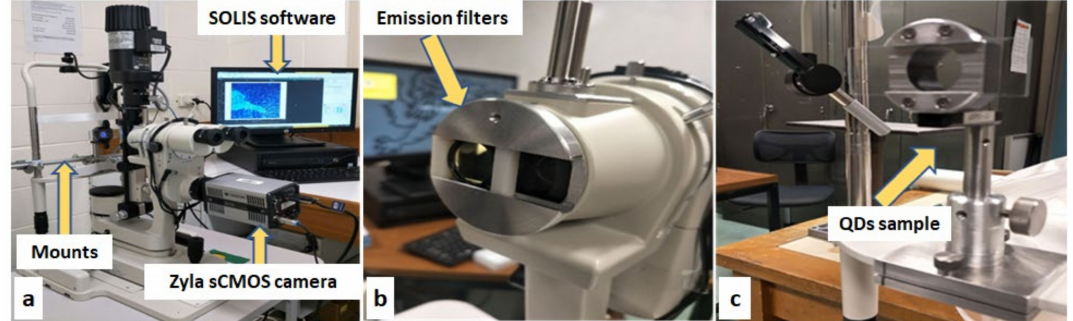
Figure 1. Modified slit-lamp biomicroscope for the in vitro imaging of Quantum Dots (QDs). ( a ) A Zyla sCMOS camera with SOLIS software. ( b ) The emission filter, in front of the objective lens. ( c ) QDs sample holder at the position of the chin